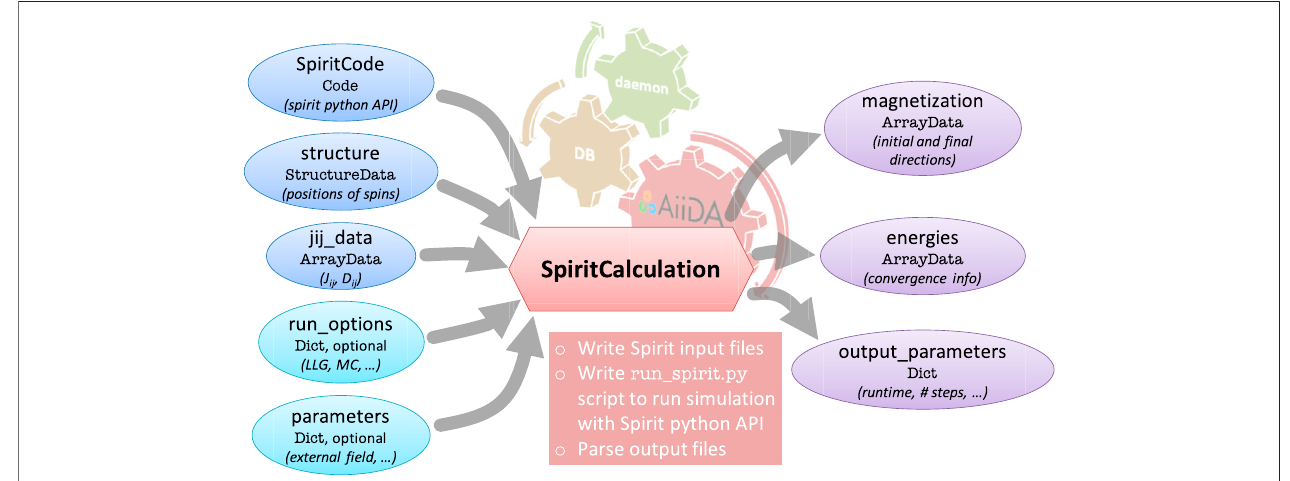
FIGURE 1 | Layout of the SpiritCalculation that is at the heart of the AiiDA-Spirit plugin. On the left hand side the possible input nodes are shown which are translated by the SpiritCalculation into the appropriate input fi les needed to execute Spirit. The run_options and parameters input nodes are optional that default to a basic LLG calculation starting from random orientation of the spins and without external fi elds or temperature. The typical output nodes for a LLG calculation are shown on the right hand side.